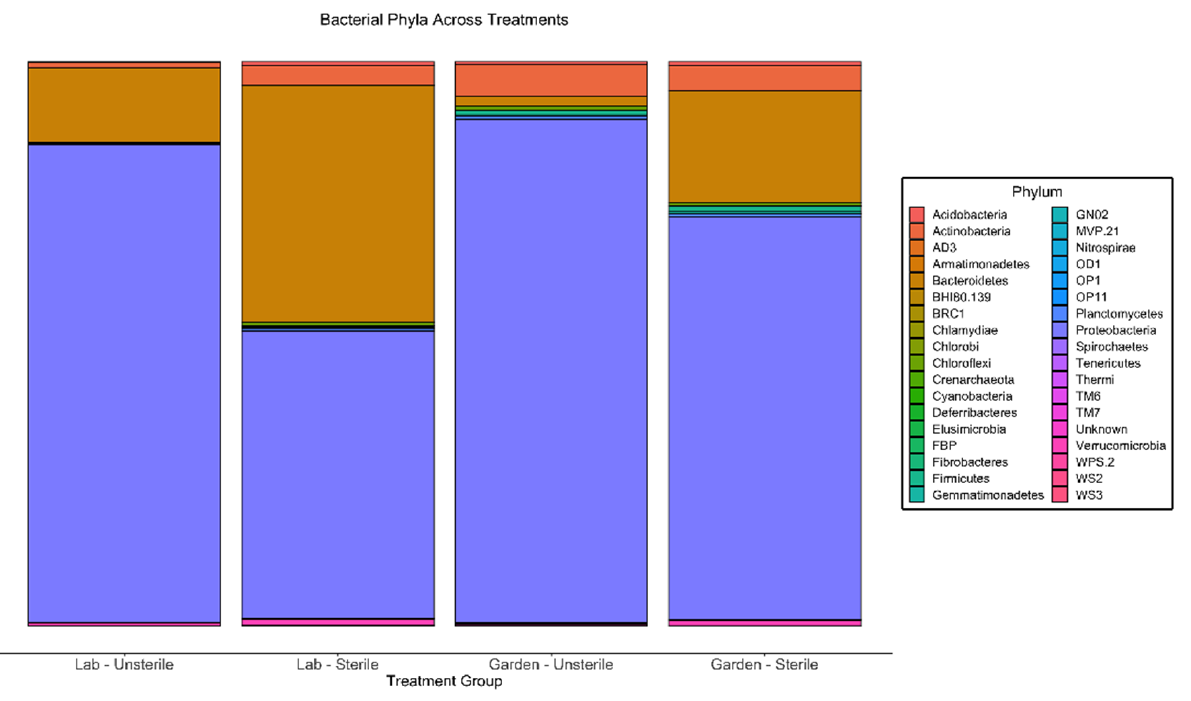
Figure 2. Relative abundances of taxa composing slug bacterial microbiomes among treatment groups, shown at the phylogenetic level of microbial phylum. The relative abundances of microbial phyla in associated treatment groups shifted after exposure to sterile conditions. Garden Unsterile N = 4, Garden Sterile N = 14, Lab Unsterile N = 4, Lab Sterile N = 5.